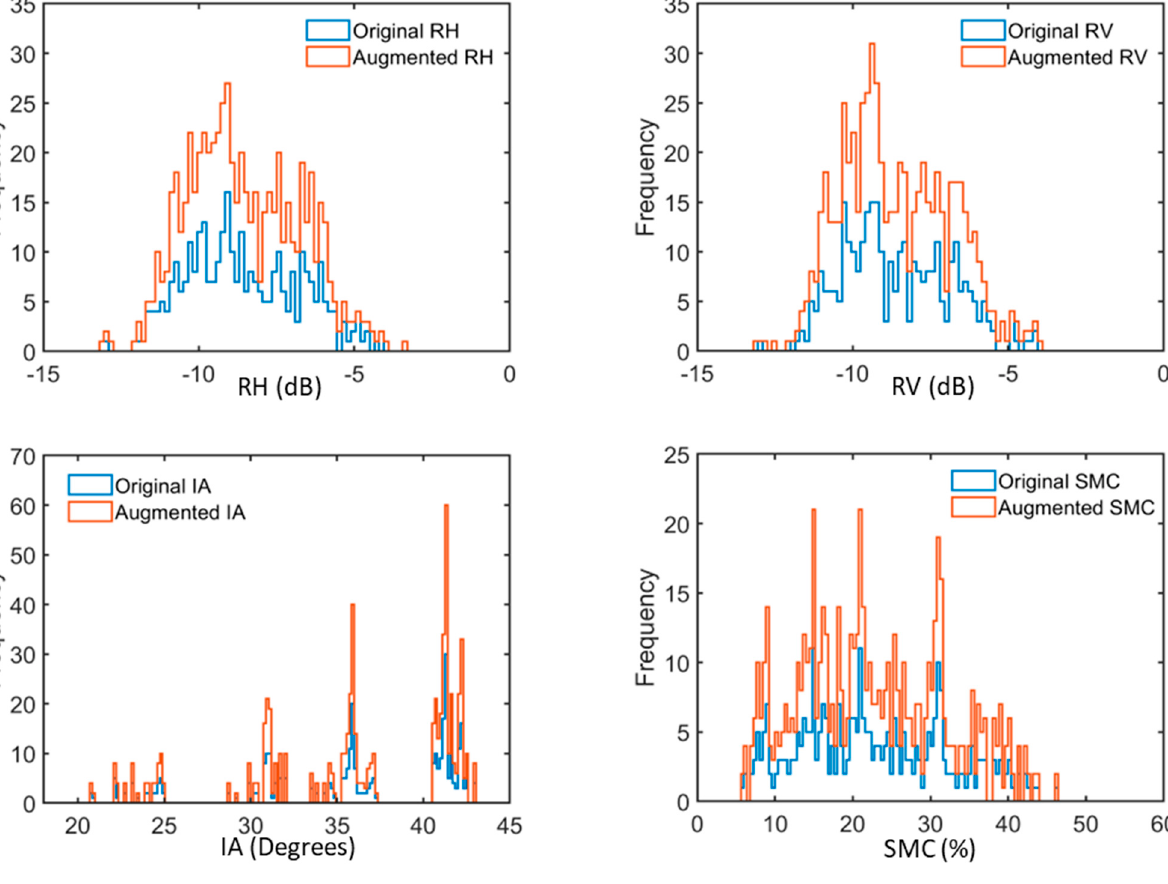
Figure 11. Histogram plots of the original dataset parameters (RH, RV, IA, and SMC) versus the SAE-based augmented parameters.